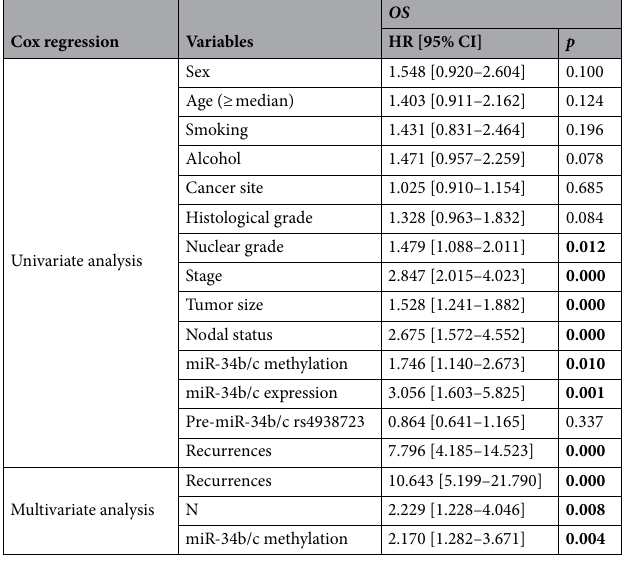
Table 2. Hazard risk analysis of prognostic factors in relation to overall survival (OS) according to Cox regression analysis, in OSCC patients. OS Overall survival, HR hazard ratio, CI confidence interval. miRNA expression dichotomized as Low and High according to ROC analysis of normalized miR expression. Significant values, p < 0.05, are